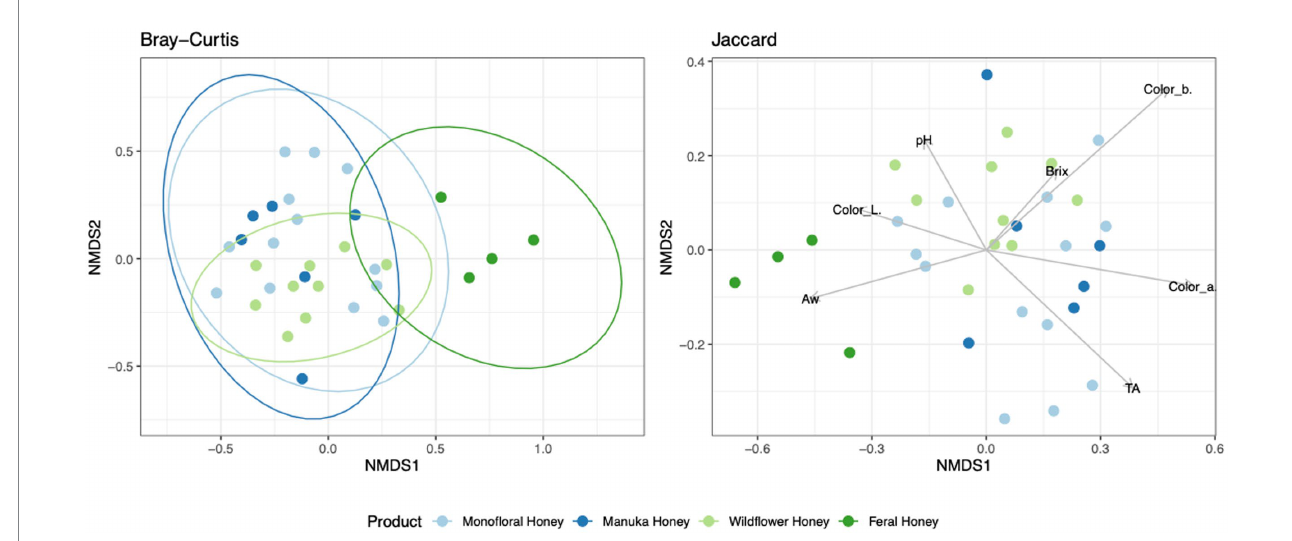
FIGURE 8 Non-metric multidimensional scaling (NMDS) ordination for fungal community structure based on the relative abundance of ITS ASVs. Community dissimilarity was evaluated with Bray–Curtis and Jaccard metrics. Ellipses indicating confidence intervals of 95% for all honey types were plotted for Bray– Curtis dissimilarity. Arrowed lines (vectors) showing correlation between physicochemical properties and Jaccard dissimilarity were plotted. The vectors represented mean direction and strength of correlation.